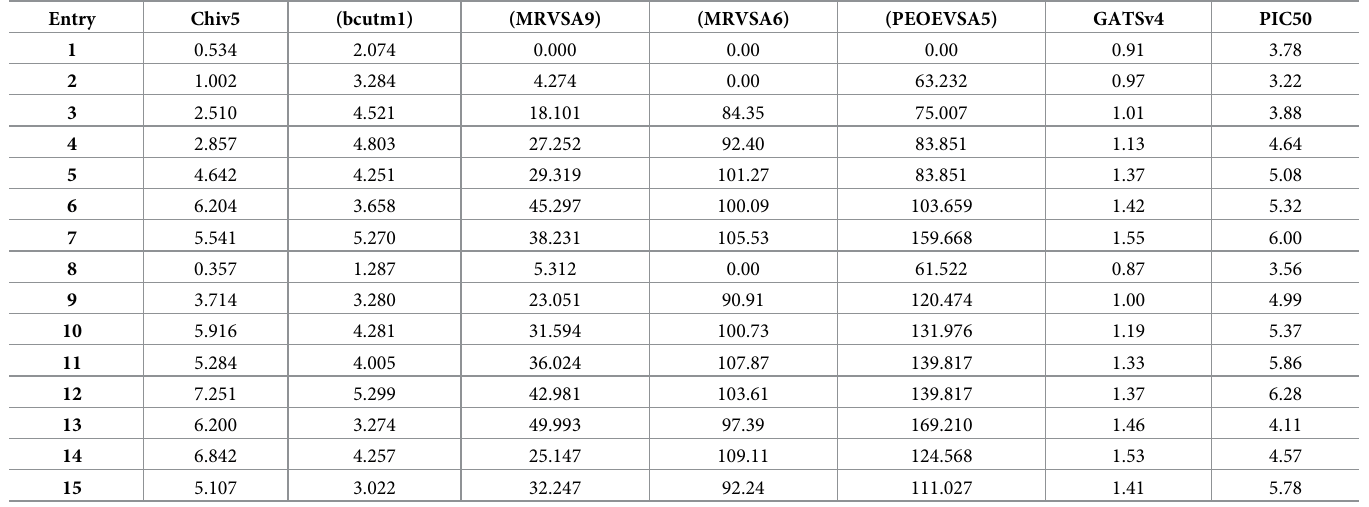
Table 5. Data of